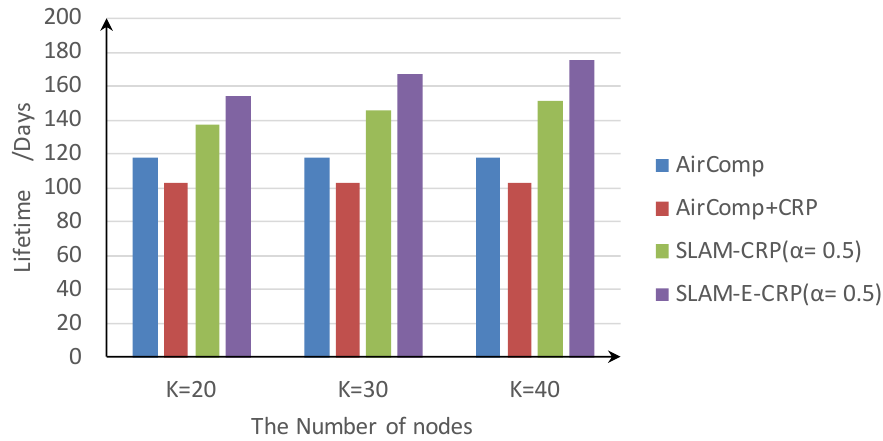
Figure 9. Variation of network lifetime with the number of nodes ( 𝛼 = 0.5 ).